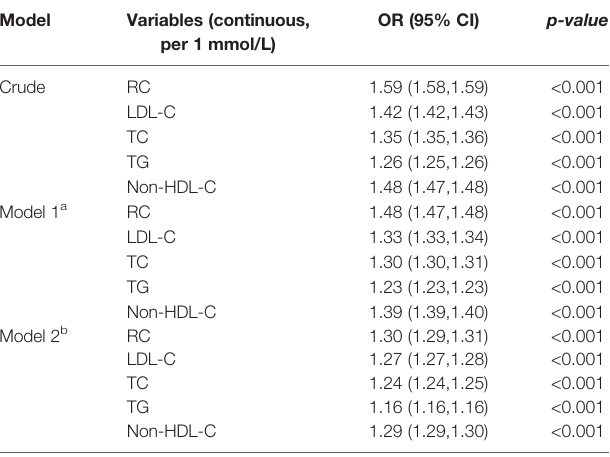
TABLE 2 | Association between lipid levels and hypertension in the cross- sectional analysis. Model